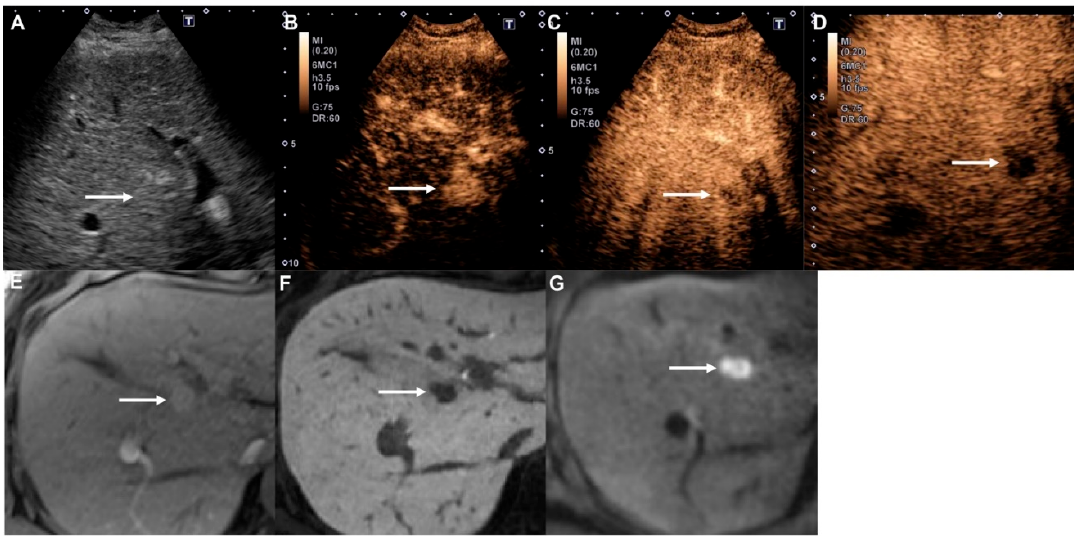
Figure 2. Poorly differentiated hepatocellular carcinoma in a 58-year-old woman with hepatitis B cirrhosis. ( A ) Gray-scale ultrasound shows a slightly hyperechoic mass (arrow) in the liver. ( B ) The nodule (arrow) shows hyperenhancement at 14 s in the arterial phase of Contrast-Enhanced Ultrasound (CEUS). ( C ) Early washout is apparent (arrow) at 40 s in the portal venous phase. ( D ) The nodule (arrow) shows a contrast defect in the Kupffer phase. ( E ) The arterial phase of Gd-EOB-DTPA-enhanced MRI (EOB-MRI) shows homogeneous hyperenhancement (arrow) in the liver. ( F ) The hepatobiliary phase of EOB-MRI shows a clear hypointense mass (arrow). ( G ) Diffusion-weighted imaging ( b = 800 s/mm 2 ) shows a clear hyperintense mass (arrow), indicating diffusion restriction.